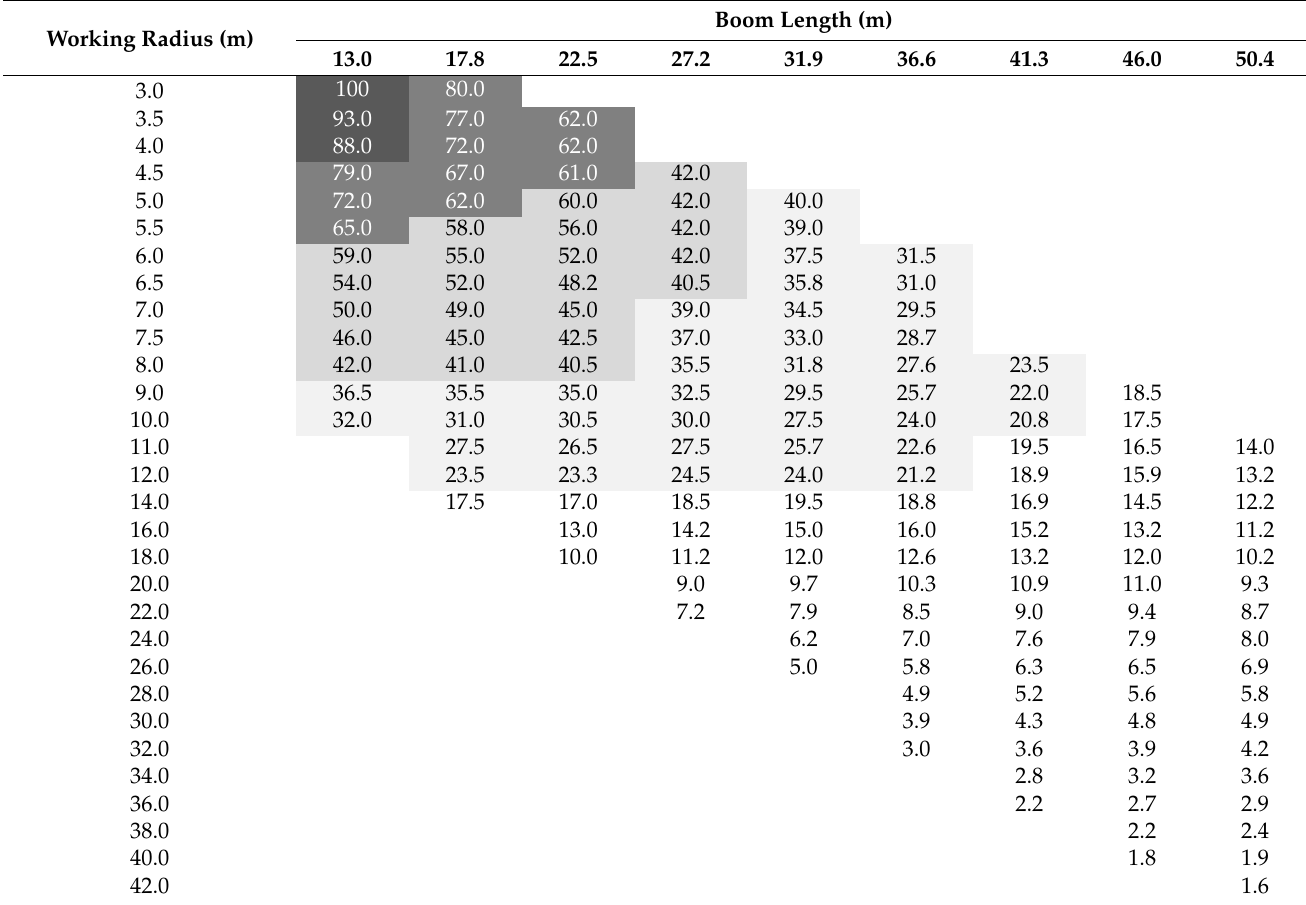
Table 4. Lift capacity of a QY100H-3 mobile crane [42,45]